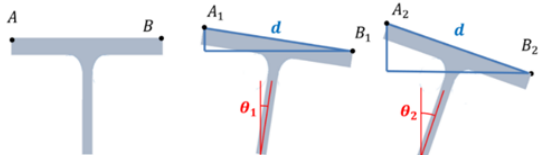
Figure 4. Twist angle thought as height differences between two upper flange points. Twist angle diagram on a pin or fixed-supported beam subjected to a punctual torque is made of two straight lines crossed at the cross section where the load is applied. The general